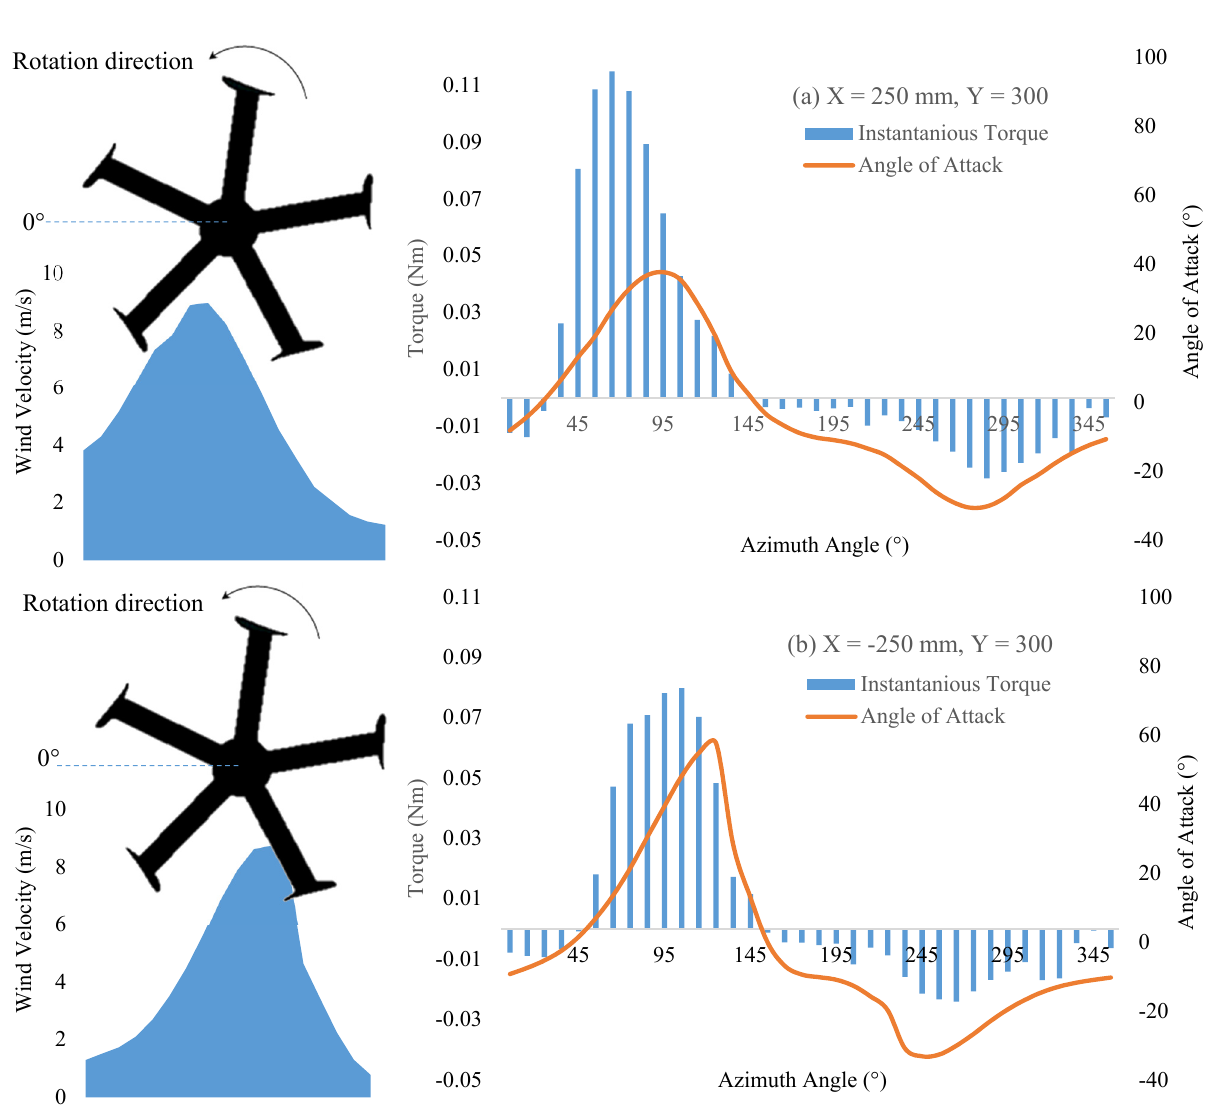
Figure 12. Turbine position against wind stream, power against azimuth angle, and angle of attack versus azimuth angle at horizontal positions of X = 250 mm and X = − 250